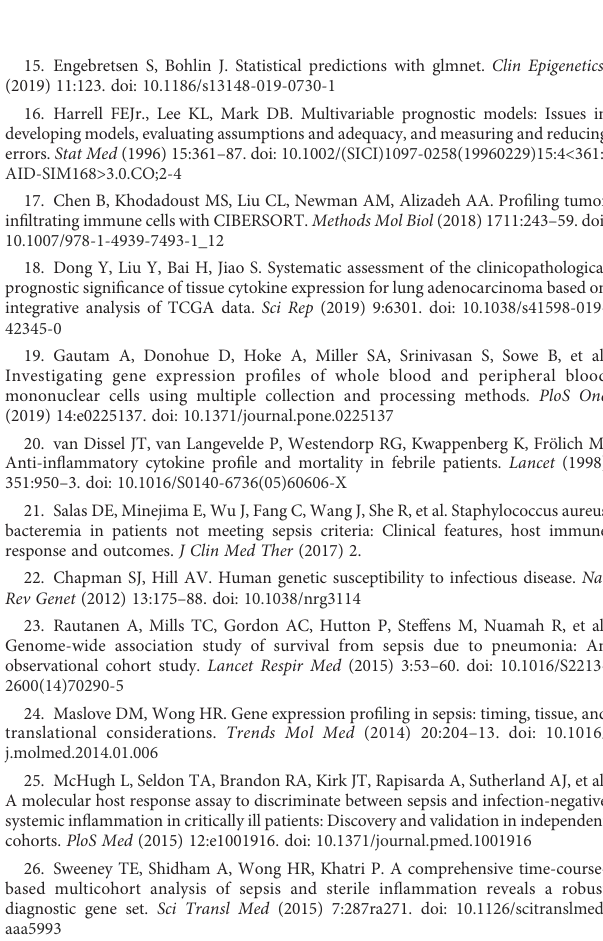
SUPPLEMENTARY FIGURE 1 WGCNA of sepsis patients (n = 479) and healthy controls (n = 42) in GSE65682. (A) Sample clustering to detect outliers. (B) Analysis of the scale-free fi t index (left panel) and the mean connectivity (right panel) for various soft-threshold powers. R 2 = 0.988 and b = 8 (red line) were selected for the subsequent analysis. (C) Cluster dendrogram (unmerged) of co- expression network modules ordered by a hierarchical clustering of genes and based on the 1-TOM matrix. Different colors represent different modules. (D) Clusteringof module eigengenes. Modules whosedistance were lessthan 0.25 (red line) were merged. (E) Cluster dendrogram (merged) of co- expression network modules. (F) Module membership (MM) versus gene signi fi cance (GS) plot of the brown module. SUPPLEMENTARY FIGURE 2 ROC analysis of the sensitivity and speci fi city of 28-day survival prediction in E-MTAB-4451 (n = 106). SUPPLEMENTARY FIGURE 3 Immune cell fractions of sepsis patients in GSE65682 (n = 479) analyzed by CIBERSORT